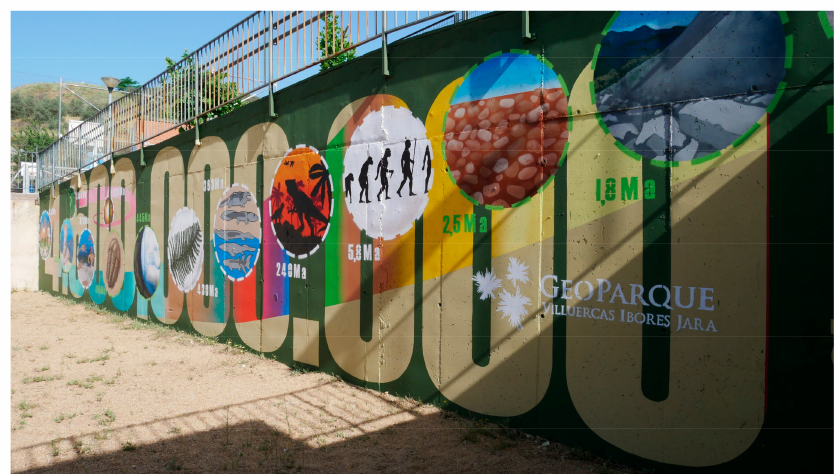
Figure 5. Time wall (Fausto Maldonado School). Source: UNESCO Global Geopark Villuercas-Ibores-Jara [56].